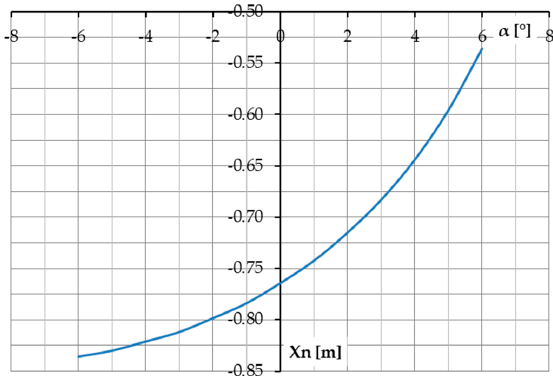
Figure 14. Neutral point position variation with the angle of attack (note that reference system begins at the “engine frame”, see Figure 12).